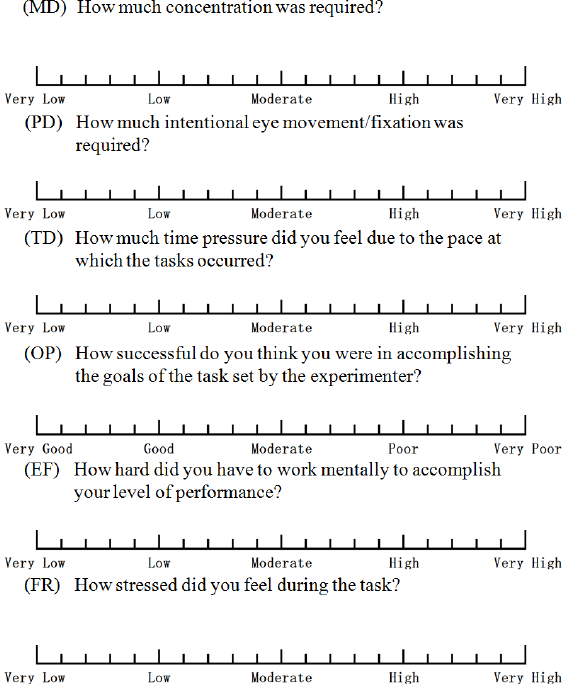
Fig. 2.Partly Modified NASA-TLX for workload evaluation of gaze writing systems